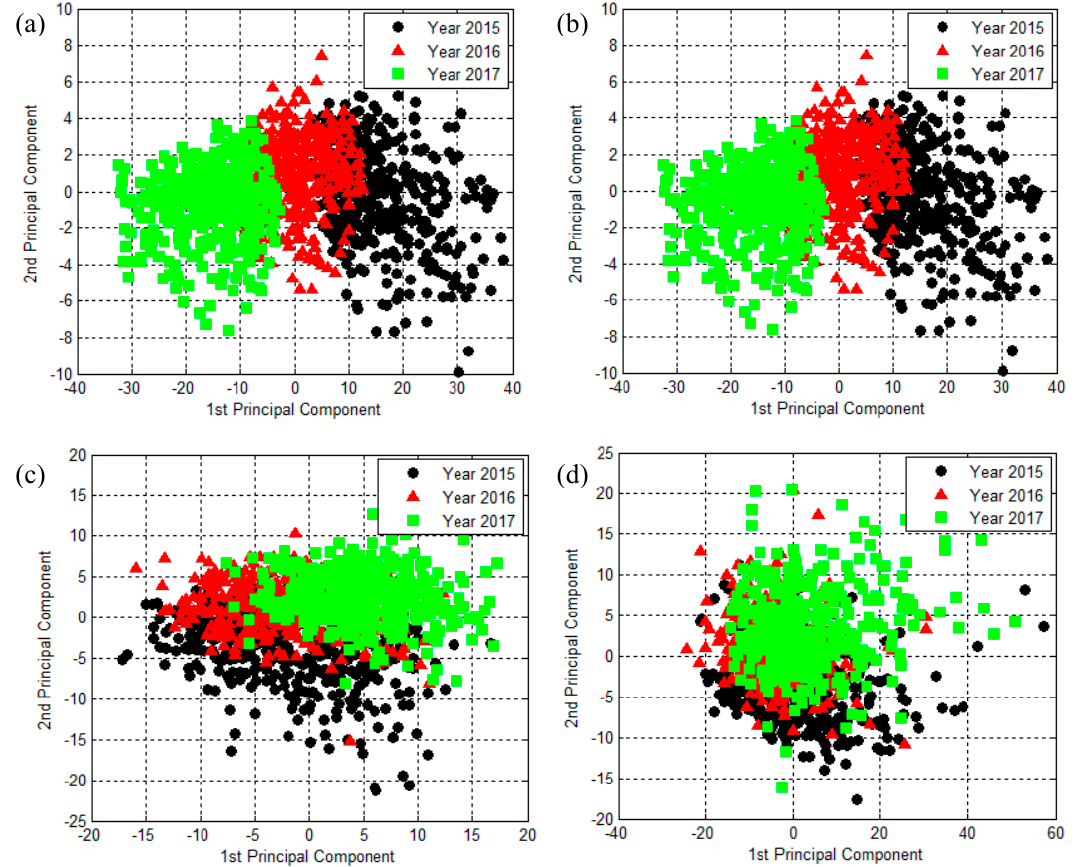
Figure 3. PCA results for ( a ) raw data and preprocessed data of ( b ) Savitzky–Golay (SG), ( c ) Savitzky–Golay first derivative (SG-D1) and ( d ) multiplicative scatter correction (MSC), based on the spectral data of rice seeds of different years.